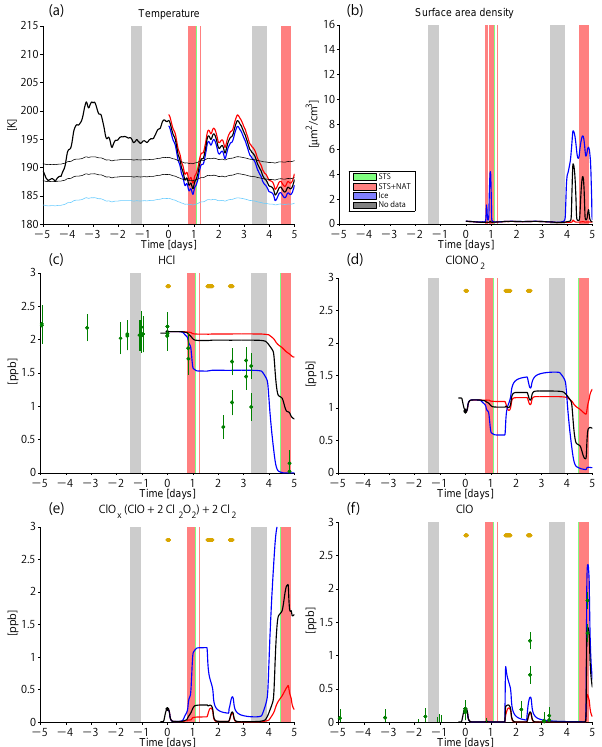
Figure 14. Temperature sensitivity runs for trajectory case no. 09. Line colors here are the same as those in Fig.